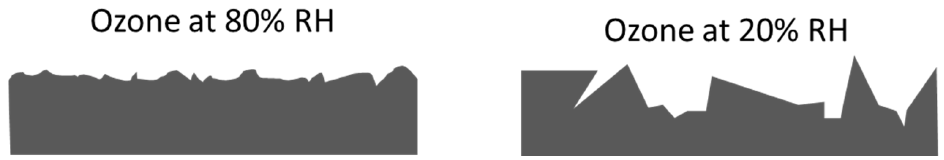
Figure 7. Simplified scheme of the ozone action under different humidity conditions [56]. Regardless of the application, UV-ozone treatment influences the surface behavior of rubber and other polymers. As summarized with the Table 2, the adhesion by the binder is the most wanted property, and this should have a potential effect even for the final rubberized asphalt or other binder applications. However, it has to be controlled to avoid deep degradation of the rubber and lead to a decrease of the elastic properties. The concentration of ozone, the distance of the UV radiation, and the humidity during the treatment must be controlled and can make this treatment less advantageous for treating large quantities of Table 2. Summary of the studies on the procedures and results using UV ‐ ozone treatment. Reference Method/Procedures